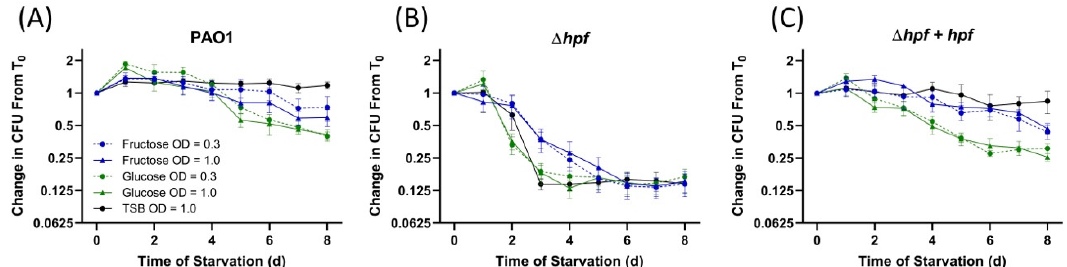
Figure 6. E ff ect of nutrient source and pre-growth conditions on subsequent resuscitation of P. aeruginosa from starvation. Strains were cultured in MOPS minimal medium with glucose (green) or fructose (blue) to O.D. 600 = 0.3 (dashed lines) or O.D. 600 = 1.0 (solid lines). Data are plotted as fold-reduction over 8 d of starvation and compared to strains pre-cultured in TSB to O.D. 600 = 1.0 (black lines). ( A ) Fold-change in recoverable cell numbers for the wild-type strain, P. aeruginosa PAO1. ( B ) Fold-change in recoverable cells for P. aeruginosa ∆ hpf . ( C ) Fold-change in recoverable cells for P. aeruginosa ∆ hpf complemented with hpf . All data show the mean and standard error of at least three independent biological